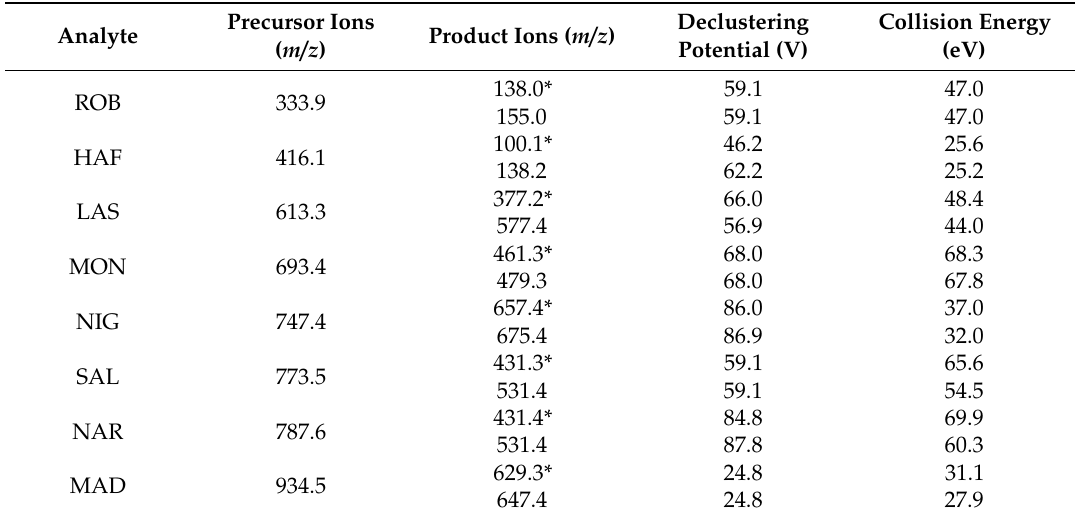
Table 1. Mass spectral parameters, precursor ions, and product ions of eight coccidiostats.